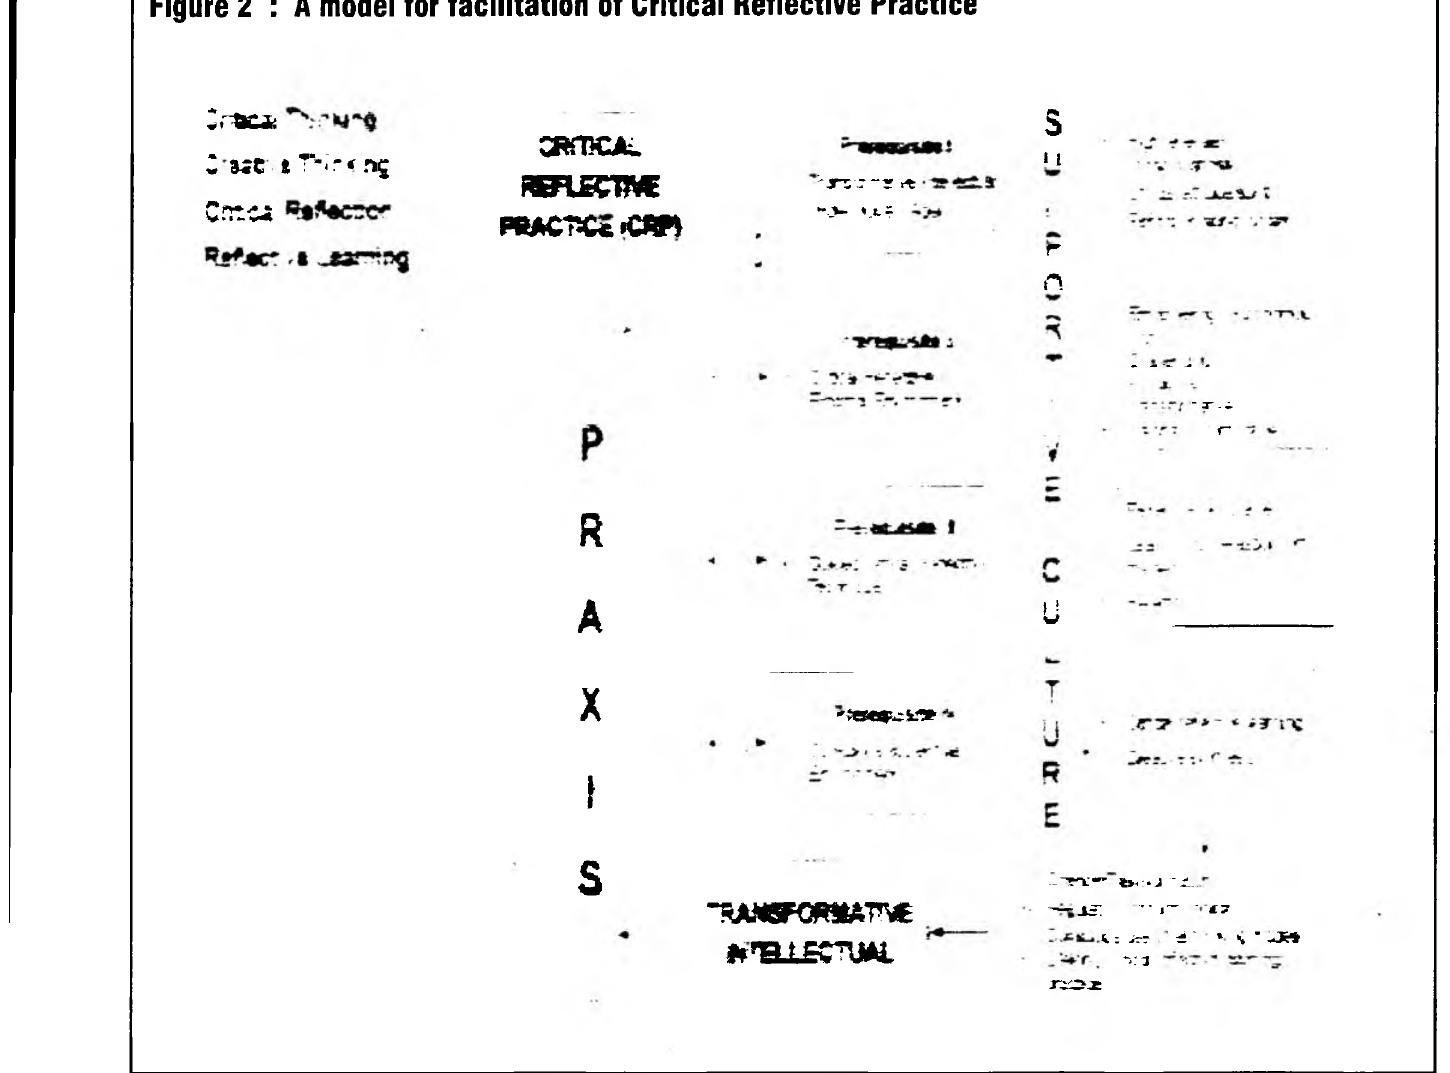
Figure 2 : A model for facilitation of Critical Reflective